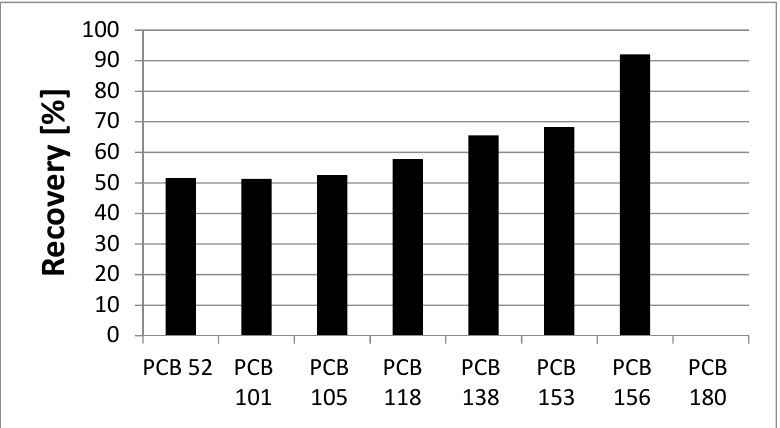
Figure 2. Recovery of PCB (polychlorinated